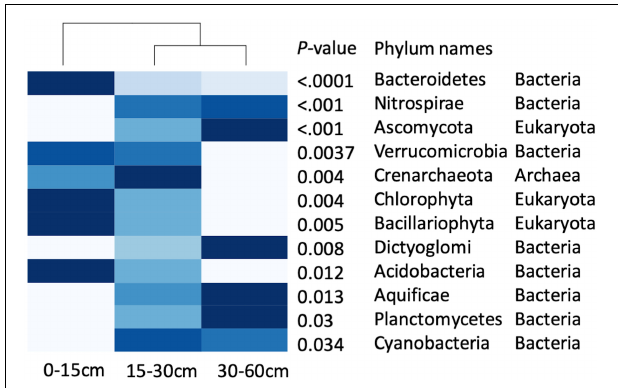
FIGURE 2 | Heatmap of the taxonomic profiles at the phyla level in three soil depths, showing the relative abundances of phyla in each soil depth ( n = 15), the deeper the blue cell, the higher the relative abundance of functions. Differences in phyla among soil depths are indicated by p -values <